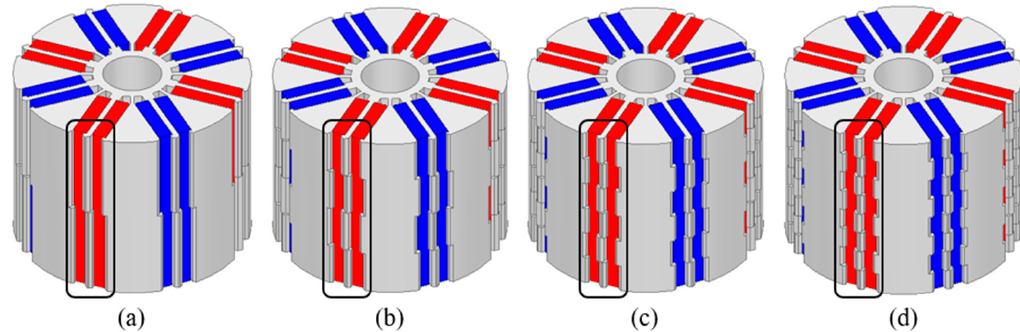
Figure 15. 3D rotor model. ( a ) 2-step model; ( b ) 4-step model; ( c ) 6-step model; ( d ) 8-step model.